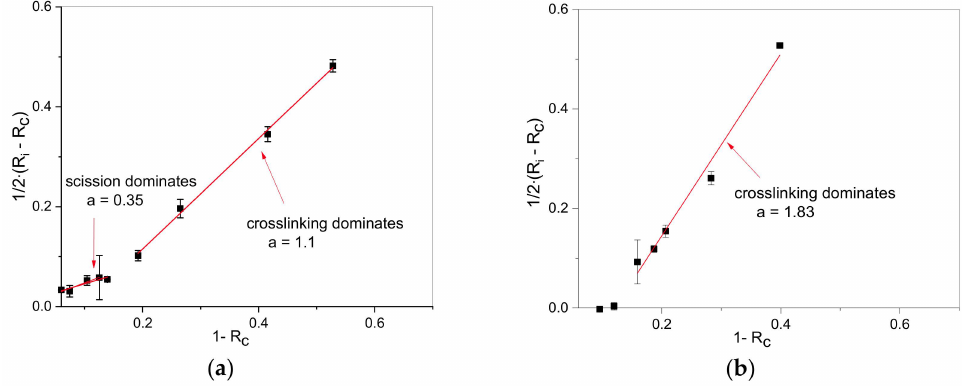
Figure 3. Evolution of cross-linking versus scission at 125 ◦ C for: ( a ) EPDM; ( b ) HNBR.